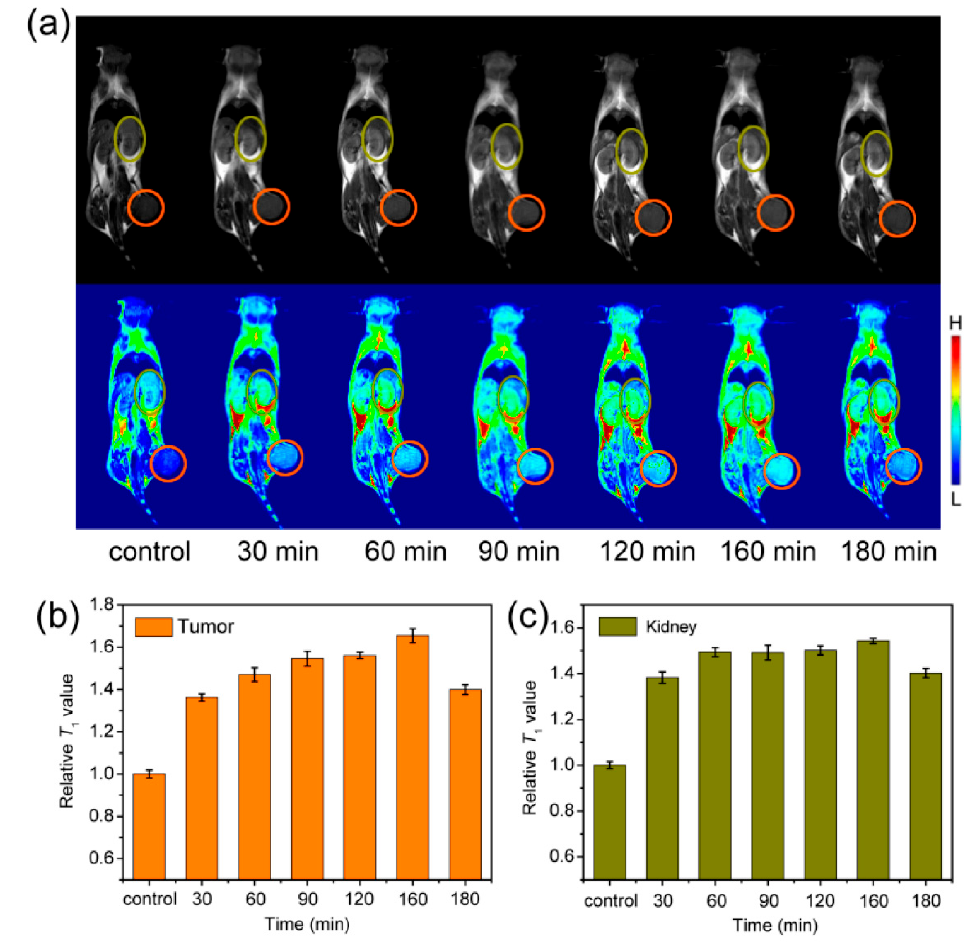
Figure 18. T 1 -weighted MR images (B 0 = 1 T) of mice collected before (control group) and after intravenous injection of Fe 3 O 4 -PAA at time points of 30, 60, 90, 120, 160, and 180 min ( a ). The corresponding relative T 1 -weighted signals extracted from ( b ) tumor (orange circle) and ( c ) kidney (dark yellow circle) sites (adapted from [118]).